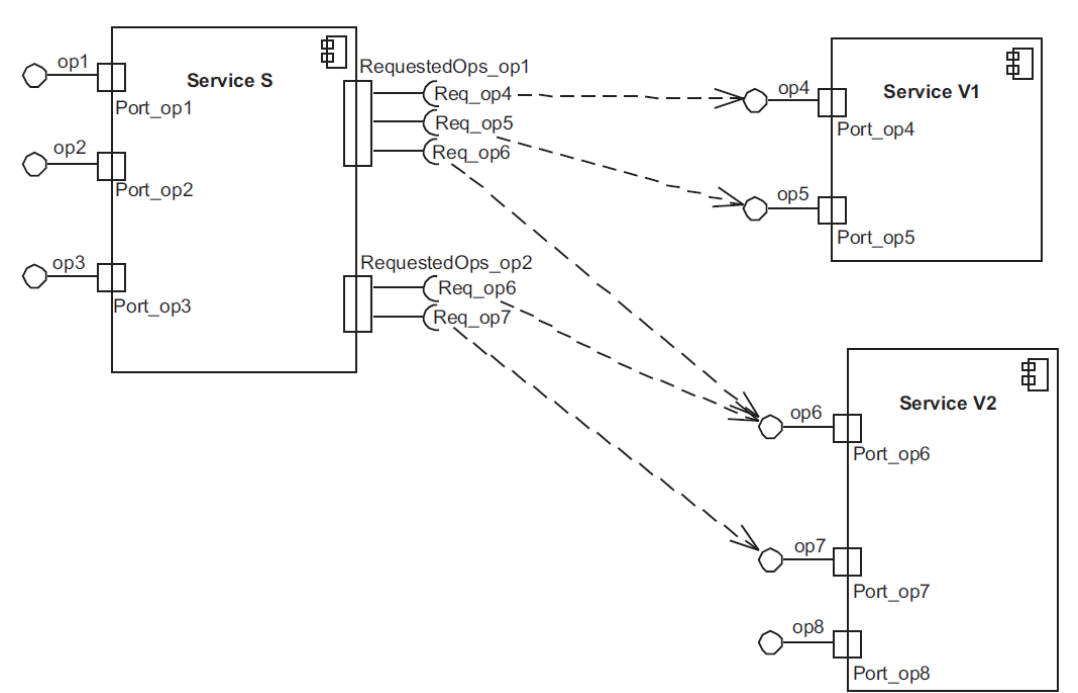
Figure 2. A UML component diagram for modeling a